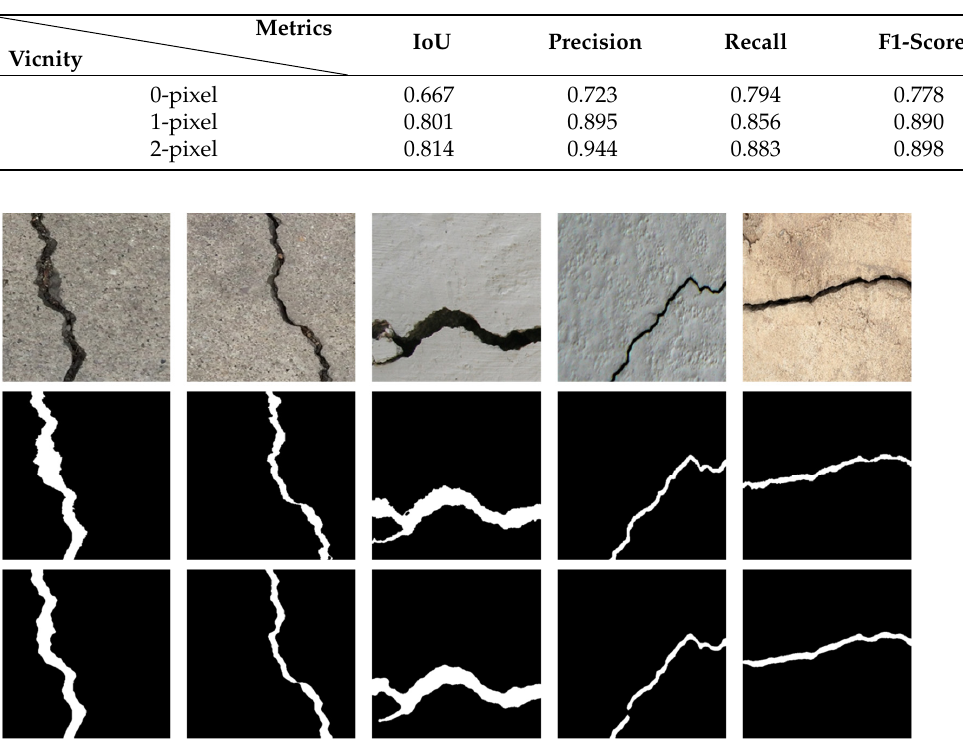
Figure 17. Five examples in the evaluation dataset: original image ( upper ), manually labeled GTs ( middle ), and prediction results (second-round GTs) obtained using our method ( bottom ).